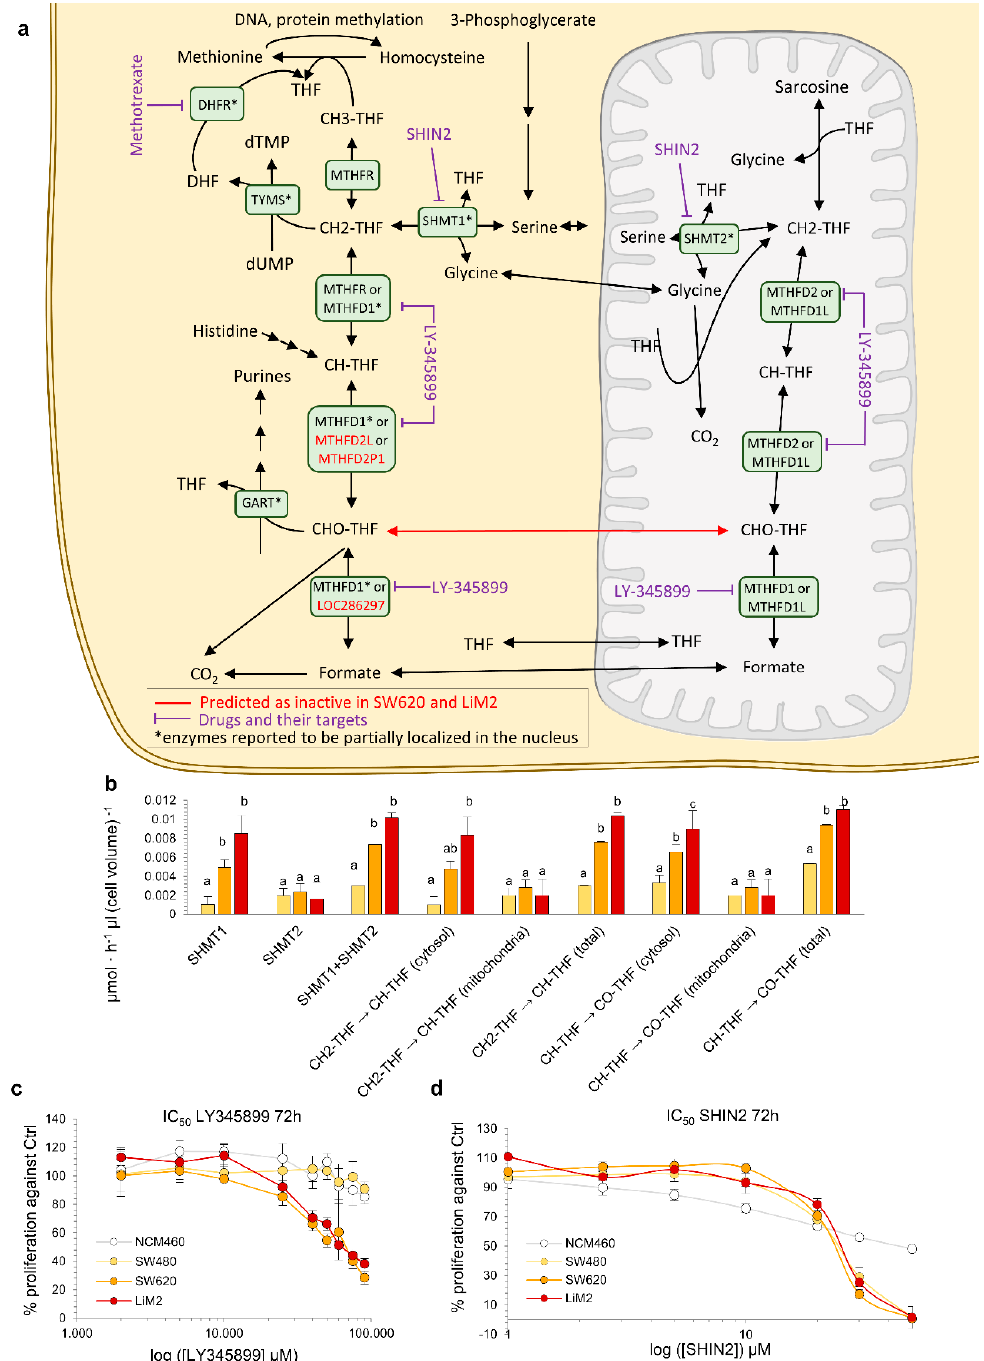
Figure 6. The metastatic cell lines are dependent on the cytosolic branch of folate metabolism. ( a ) Representation of folate metabolism. ( b ) Predicted flux values for different reactions of cytosolic and mitochondrial folate metabolism. a,b,c denote cell lines with an overlap of the sampled flux values for a given reaction. ( c ) and ( d ) Cell viability curve for the MTHFD1/2 inhibitor LY345899 ( c ) or the SHMT1/2 inhibitor SHIN2 ( d ) determined by DNA content using HO33342 after 72 h incubation. Statistical analyses of the IC 50 curves are shown in Table S3.